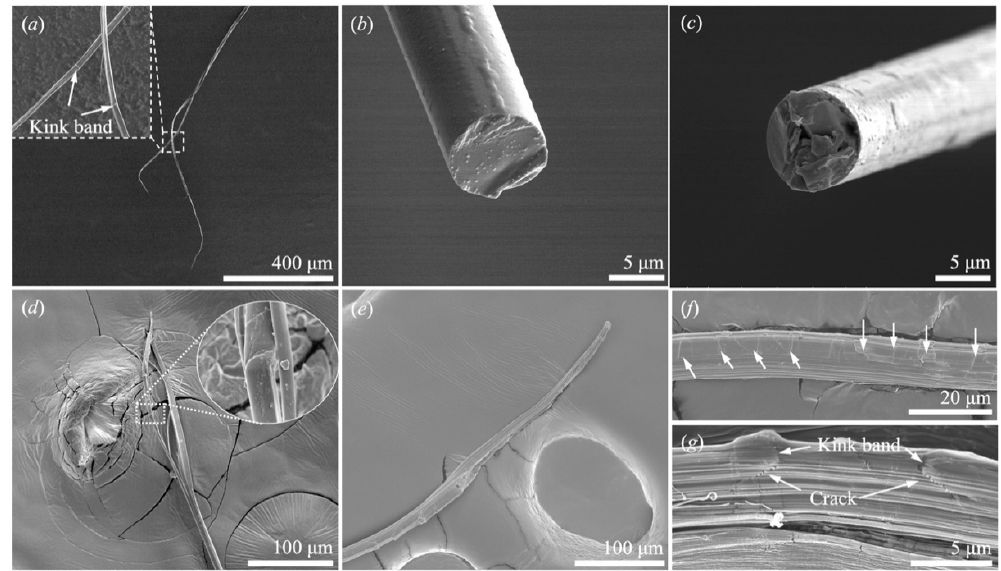
Figure 11. Fracture surfaces of different fibers. ( a ) CNT fiber; ( b ) Slyramic TM ceramic fiber; ( c ) S-2 glass fiber; ( d ) Kevlar ® KM2 Plus fiber; ( e – g ) Dyneema ® SK76 fiber.